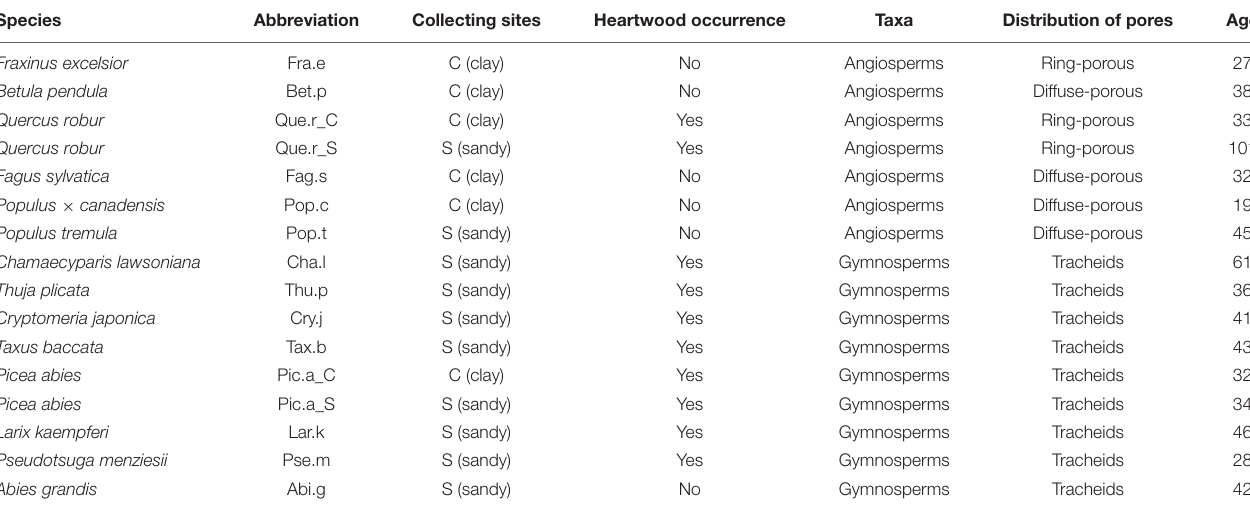
TABLE 1 | Basic information of 14 studied tree